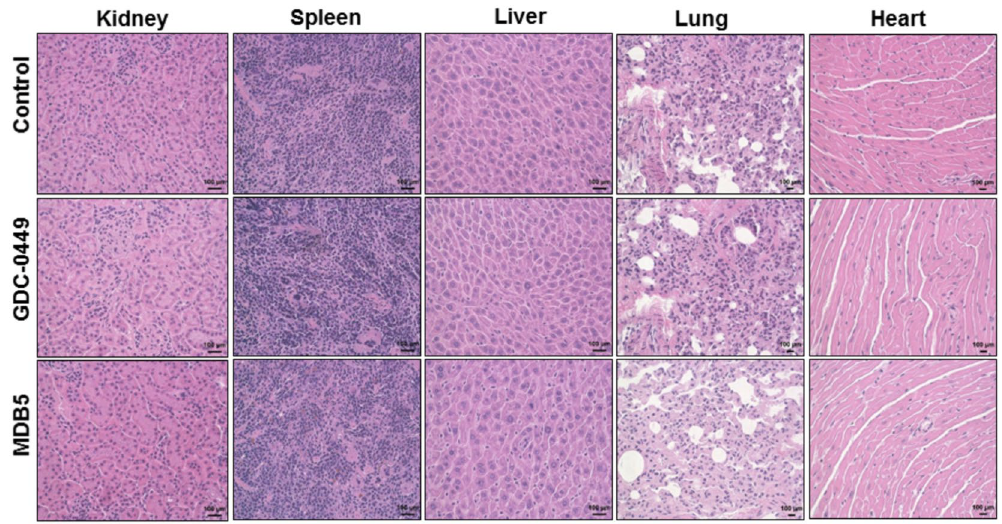
Figure 8. Immunohistochemical analysis of major organs (kidney, spleen, liver, lung and heart) by H&E staining. Scale bar, 100 µ